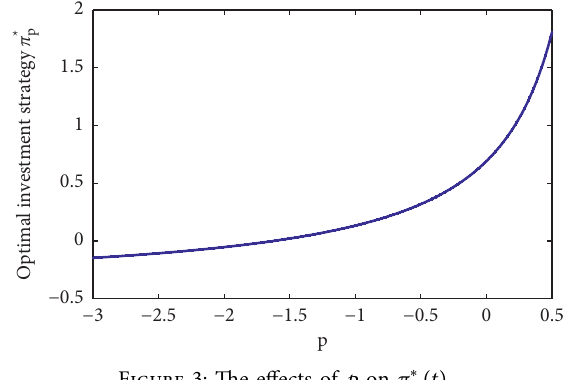
Figure 3: The effects of p on π ∗